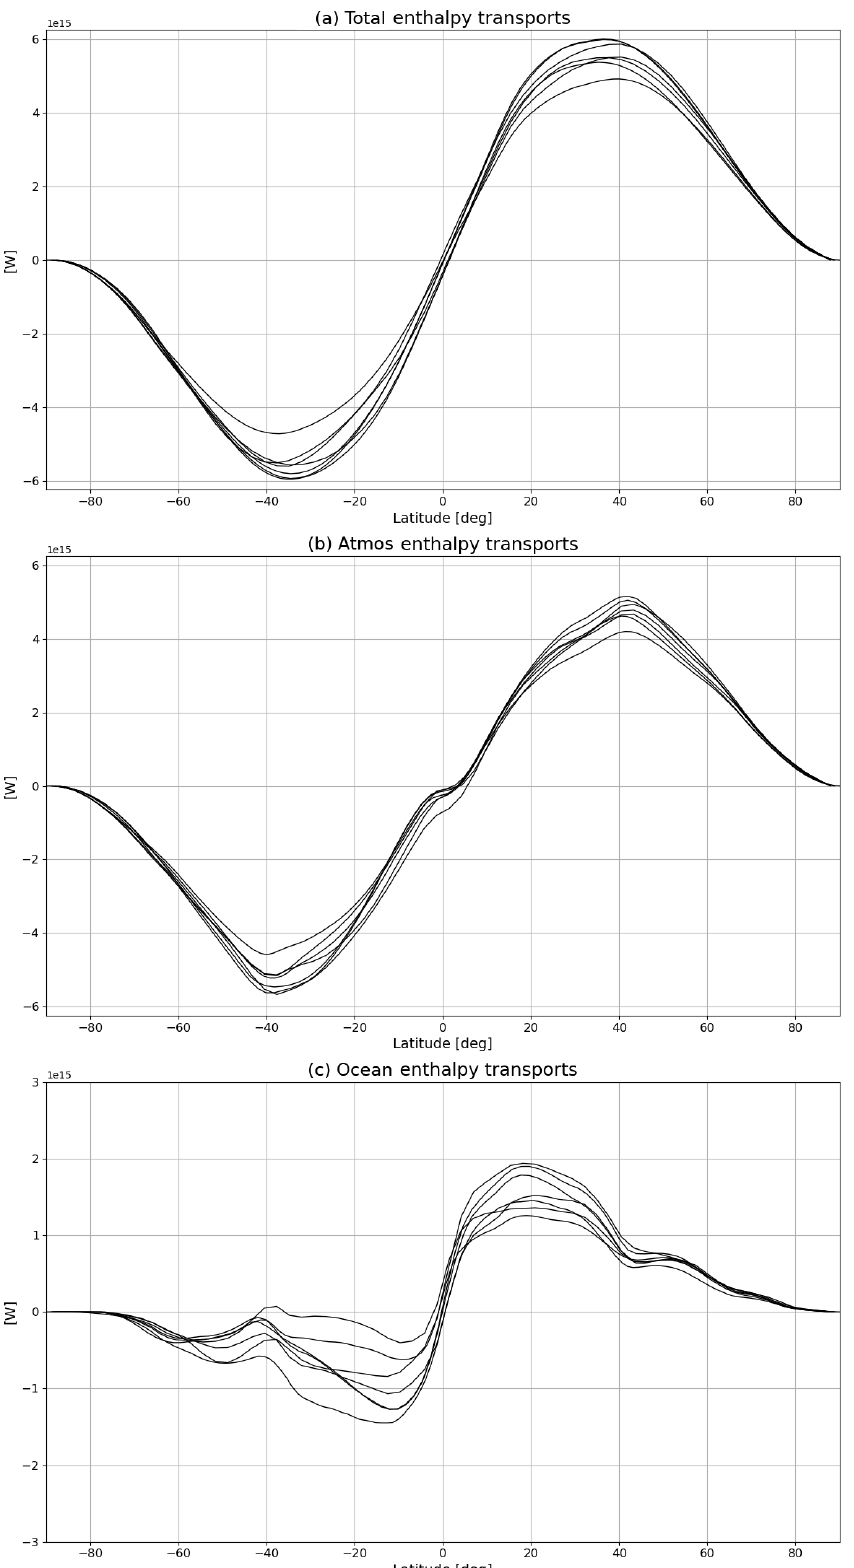
Figure 8. Climatological annual mean (a) total, (b) atmospheric and (c) oceanic northward meridional enthalpy transports for all models